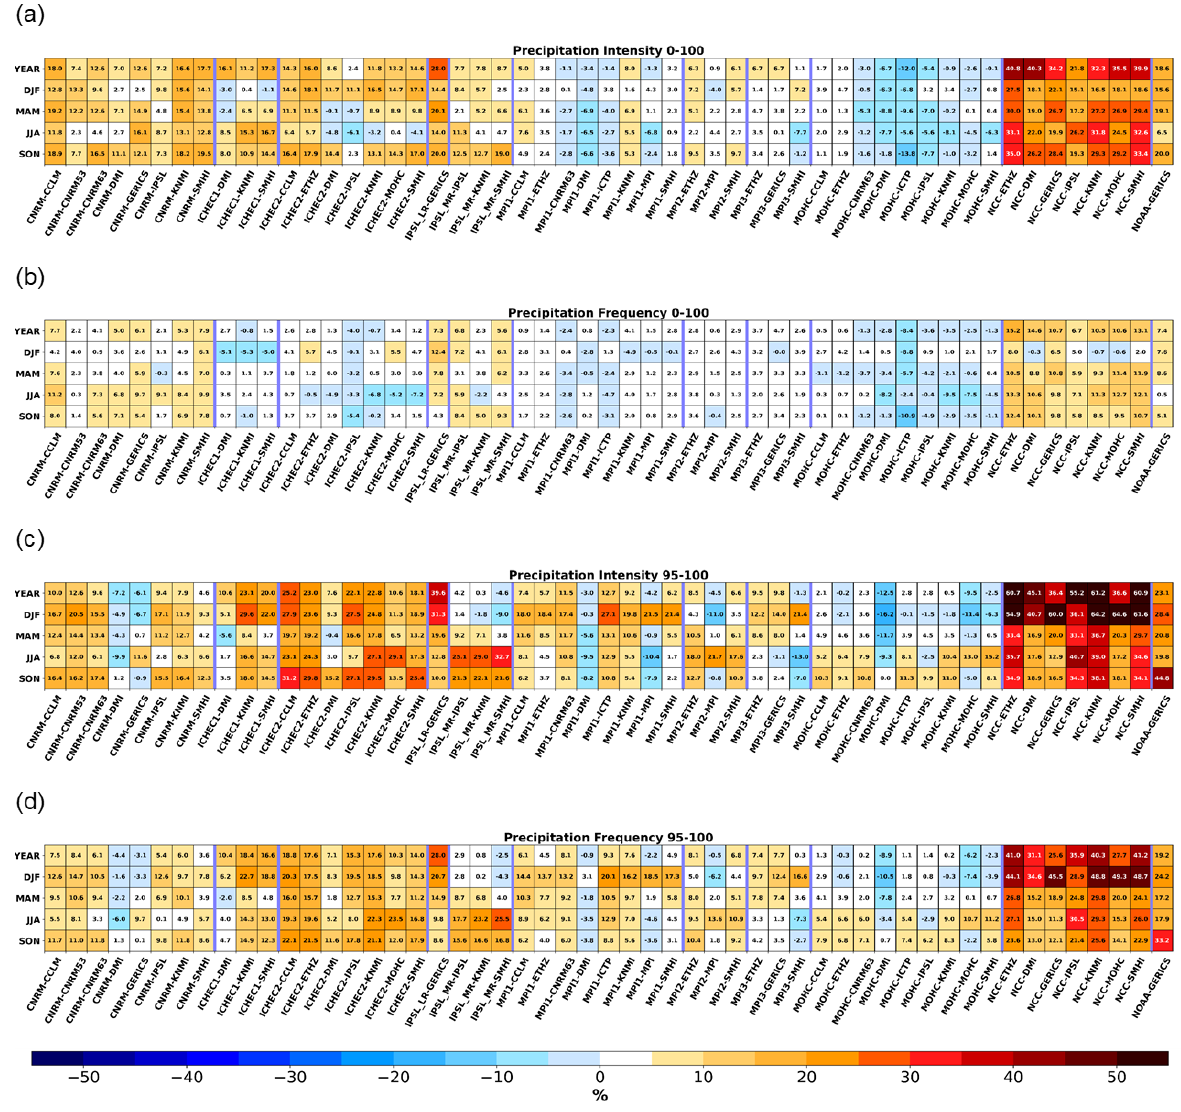
Figure 4. Yearly and seasonal distribution added values (DAVs) of the Iberian Peninsula between the RCMs and the CMIP5 GCMs for the 1989–2008 period taken from the historical EURO-CORDEX simulations, with the IGD regular dataset as a reference for (a) daily precipitation intensity considering the whole PDF shown in the left panels of Fig. S3, (b) daily precipitation frequency considering the whole PDF shown in the right panels of Fig. S3, (c) daily precipitation intensity extremes only considering the values above the observational 95th percentile shown in Fig. S3 on the left side, and (d) daily precipitation frequency extremes only considering the values above the observational 95th percentile shown on the right side of Fig. S1. All RCM data were previously interpolated to 0.1 ◦ regular resolution from the observations, while the observations were interpolated into each CMI5 GCM resolution. The thick blue lines separate the RCMs driven by a different